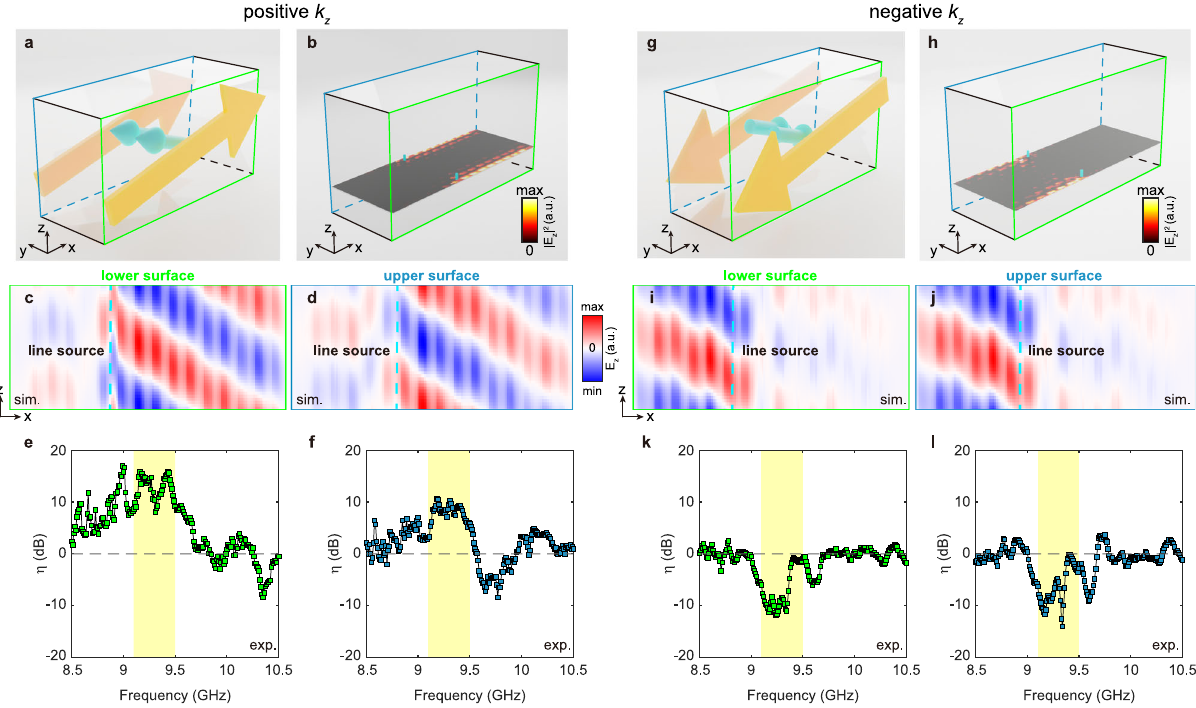
Fig. 5 | k z -dependent antichiral surface transport. Sketch of the energy fl ow for bulk modes (cyan arrows) and surface modes (orange arrows) with positive k z ( a ) and negative k z ( g ). b Simulated intensity pro fi les for k z =0.2 π / d at 9.5GHz. The cyan cylinders represent the line sources. On both surfaces, the electromagnetic waves with positive k z copropagate in the + x direction. c , d Simulated E z pro fi leon both surfaces for k z =0.2 π / d . e , f Directionality spectra in the frequency regime of